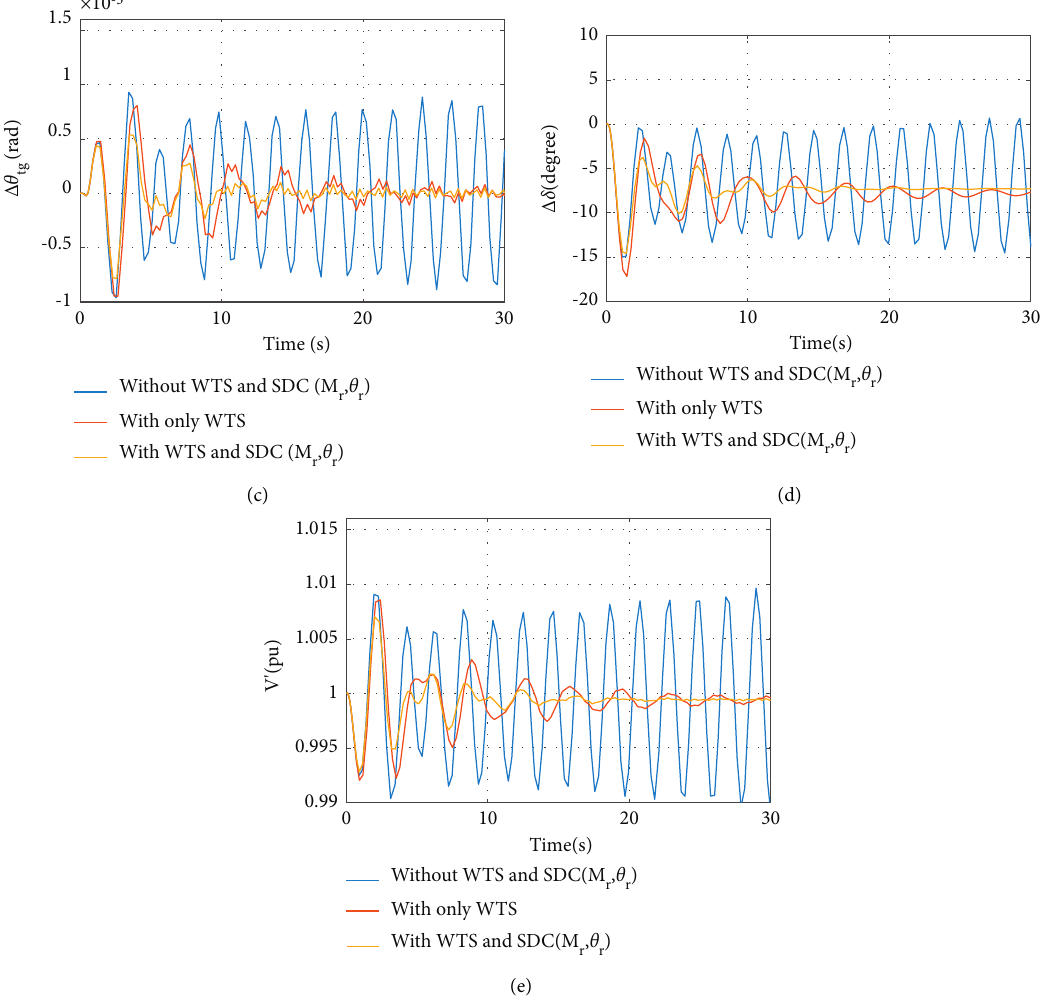
V w ≈ 8m/s). (c) The angular